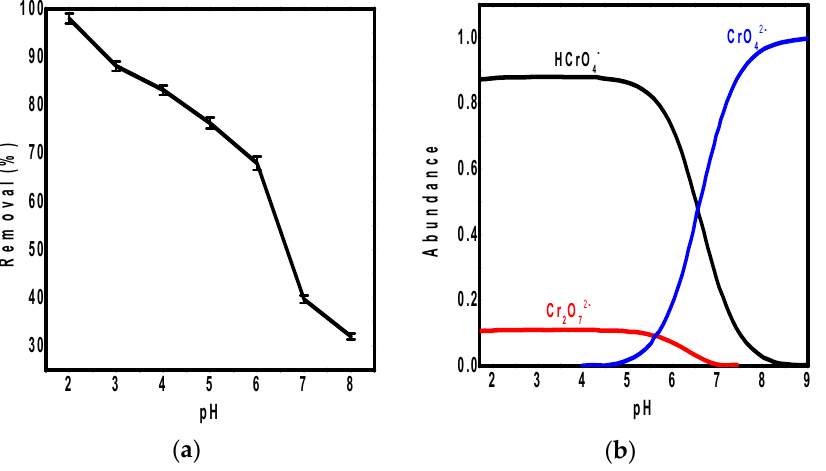
Figure 3. The effect of pH on Cr(VI) adsorption on the ppy/NC surface ( a ) and the abundance of Cr(VI) species in aqueous solution at pH range of 2 to 9 ( b ).